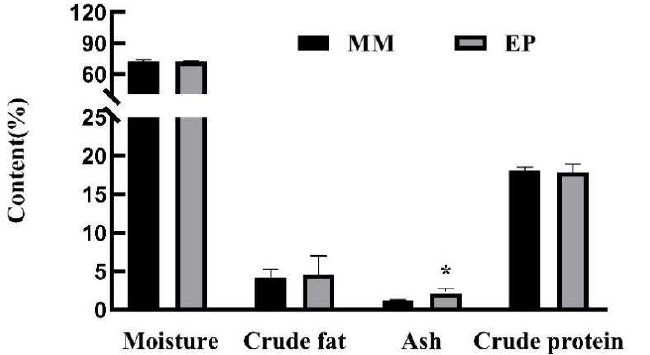
Figure 5. Proximate composition of largemouth bass muscle in the EM and EP groups. * indicates the statistically significant difference in the EM and EP groups ( p < 0.05).